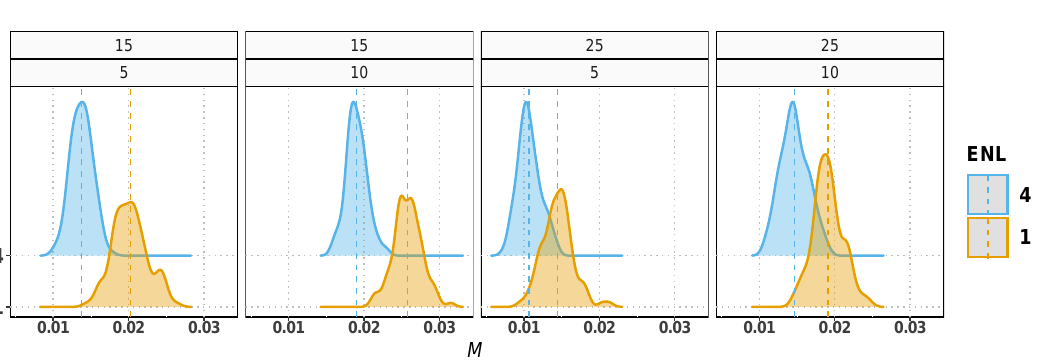
Figure 6. Kernel density estimates of the statistic The vertical dashed lines represent the mean values.